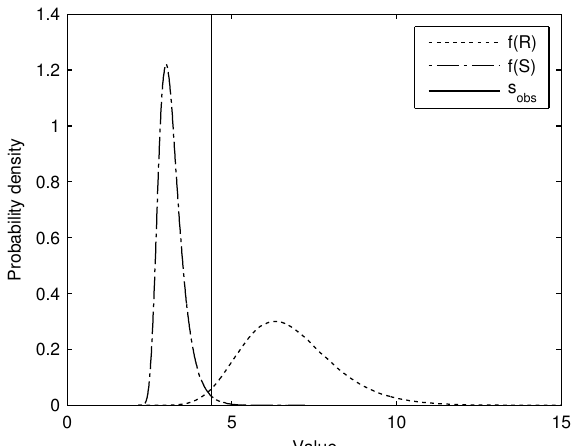
Figure 11. Prior densities of R ( R = R 1 + R 2 ) and S , and the observed load s obs = 4.38 corresponding to the 99% quantile of S ( P ( S < s obs ) =